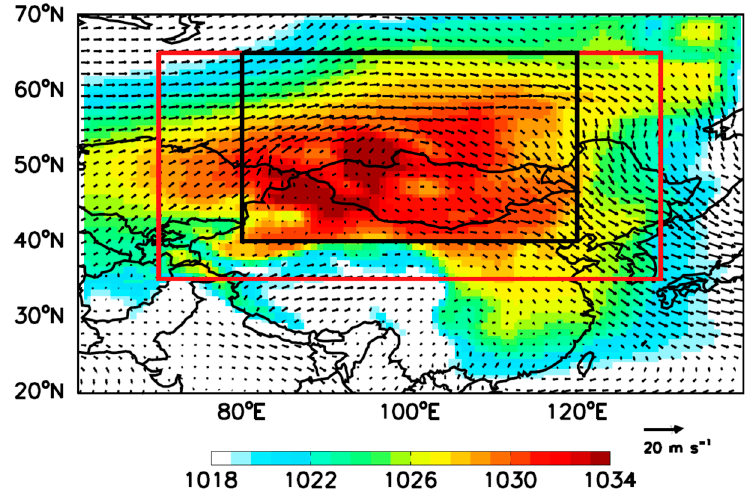
Figure 2. Multi-year (2002–2017) averaged sea level pressure (shaded) and 850 hPa wind fields (vectors) over Siberia and East Asia in winter. The black and red rectangles indicate the domains of the intensity and longitudinal center of Siberian High calculations, respectively. Units are hPa (sea level pressure) and m s − 1 (wind).